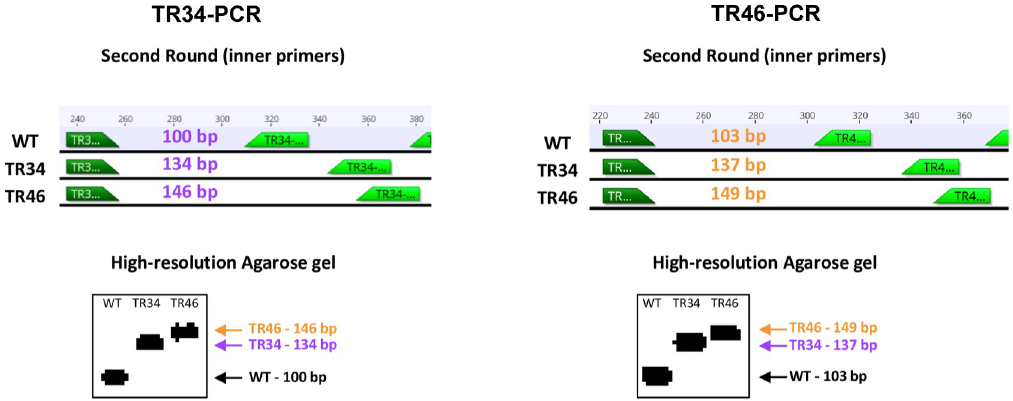
Fig 5. Fragment sizes of PCR products from the TR34-PCR and TR46-PCR assays. Sizes are shown for the A . fumigatus cyp51A wt, TR 46 , and TR 34 alleles based on the nested or second round PCR with the inner primers.